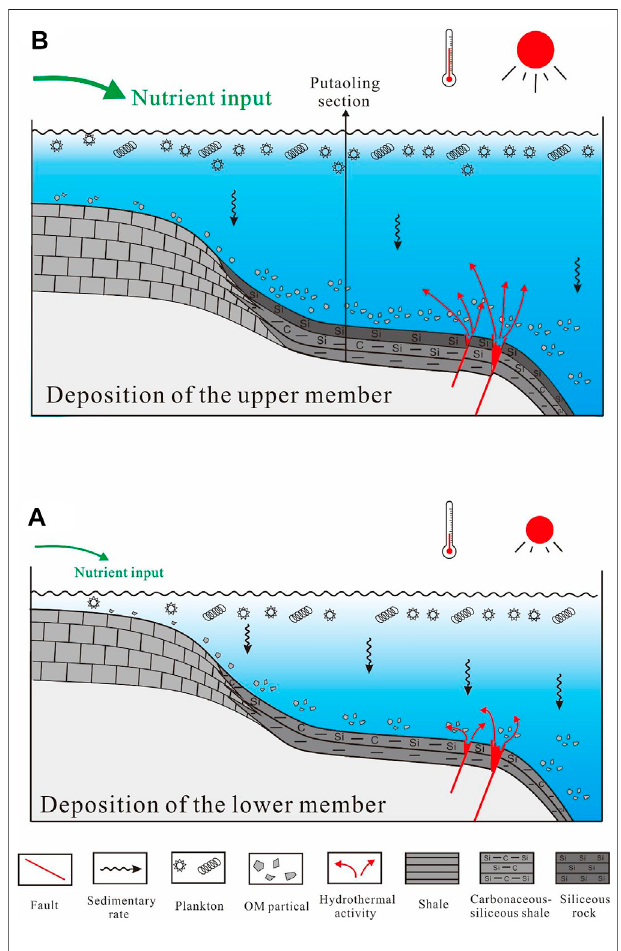
FIGURE 8 | Schematic diagram showing Permian climate, seawater redox state, distribution of black shale, hydrothermal activities, terrigenous input, and sedimentary rate in South China during (A) the deposition of the lower member and (B) the deposition of the upper member.